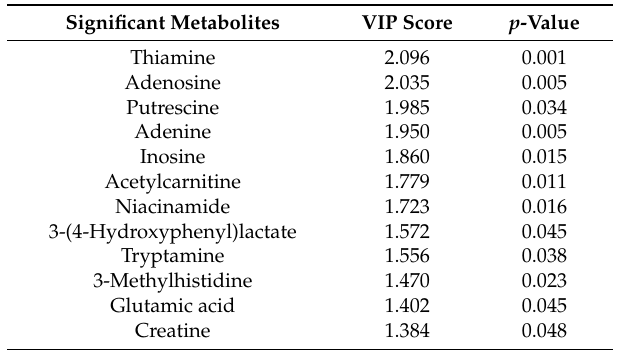
Table 1. Metabolites found to be responsible for the differentiation of rat urine samples, pre- and post-acute exercise session in both multivariate and univariate statistical approaches. VIP scores and p -values of each metabolite, sorted in descending VIP score order, are